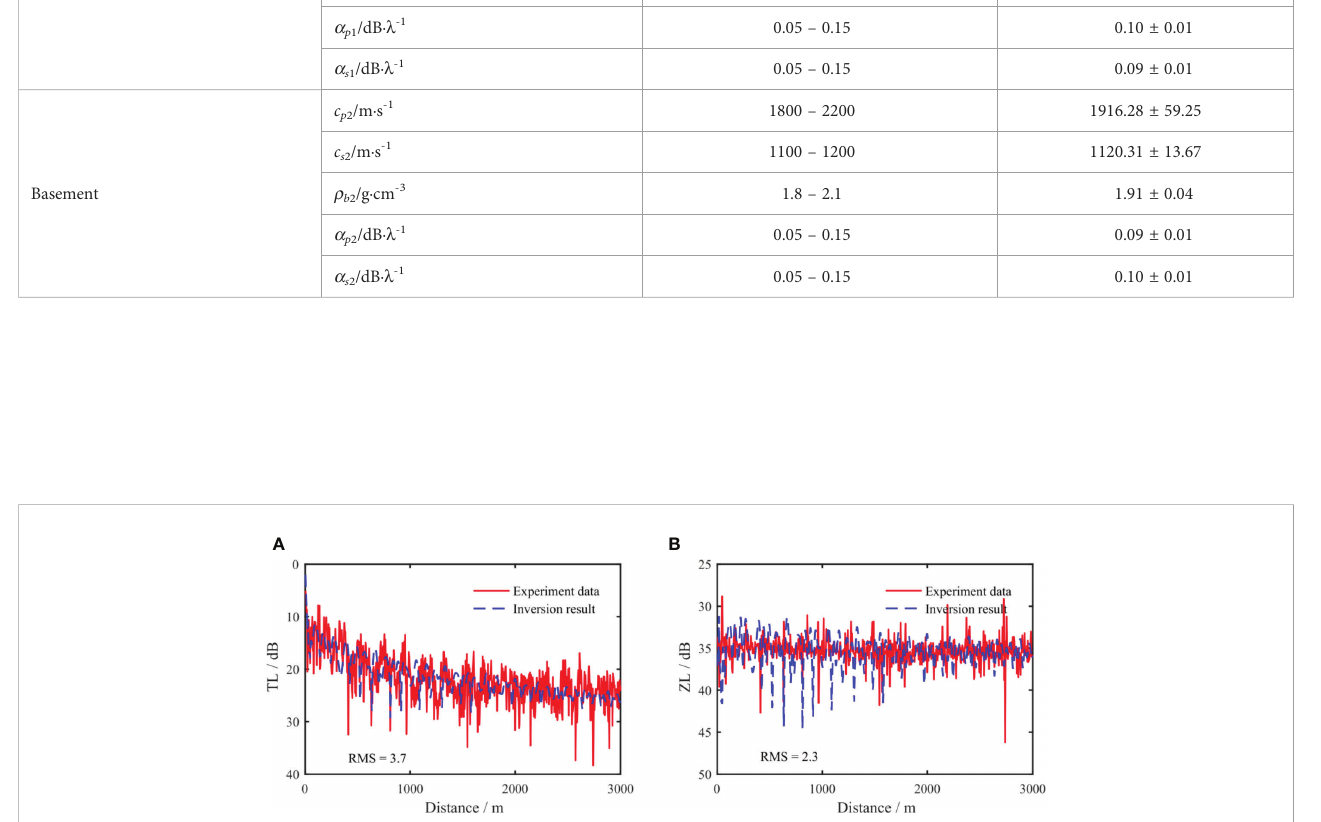
FIGURE 14 Comparison of inversion results of measured data. Acoustic pressure (A) , vertical waveguide characteristic impedance level (B) . The inversion result is the dashed line and Ex-periment data is the solid line.